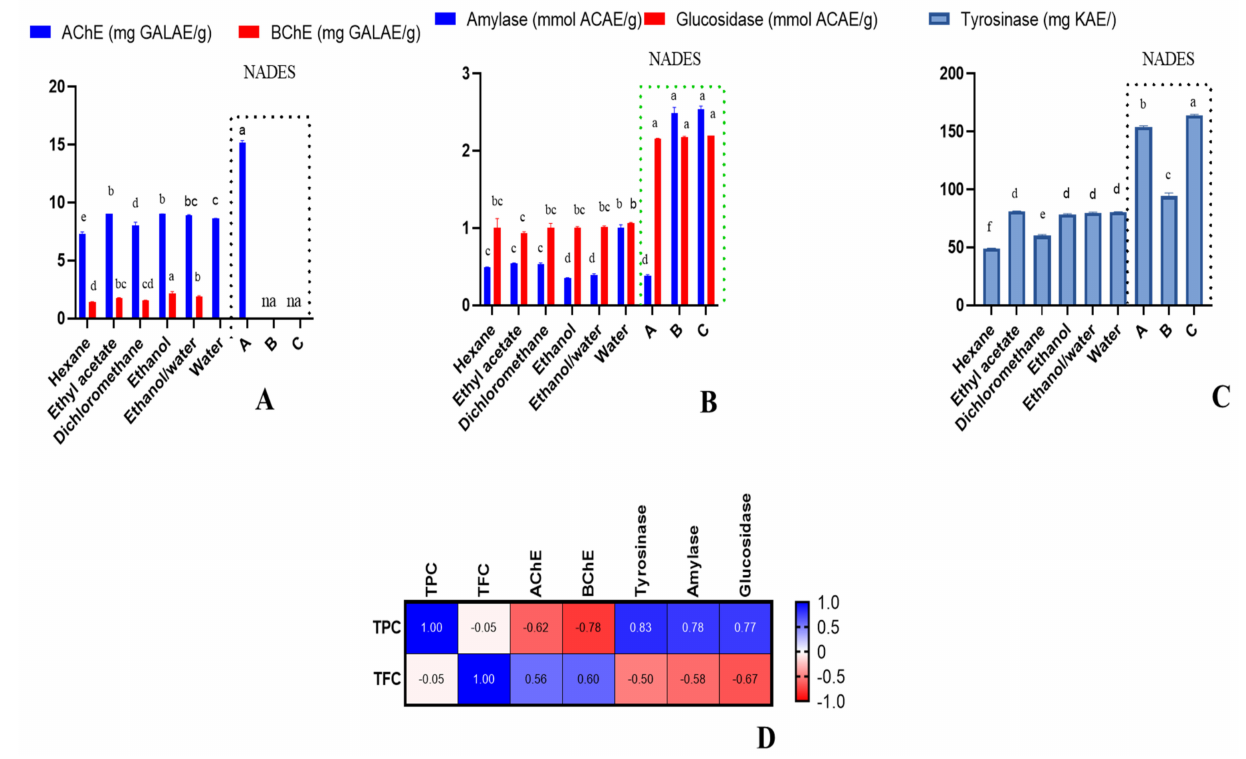
Figure 3. Cholinesterase inhibitory effects ( A ), amylase and glucosidase inhibitory effects ( B ), tyrosi- nase inhibitory effects ( C ), Pearson’s correlations between total bioactive compounds and enzyme inhibitory assays ( p < 0.05) ( D ). na: not active. Different letters in column for same assays indicate significant differences in the extracts ( p <